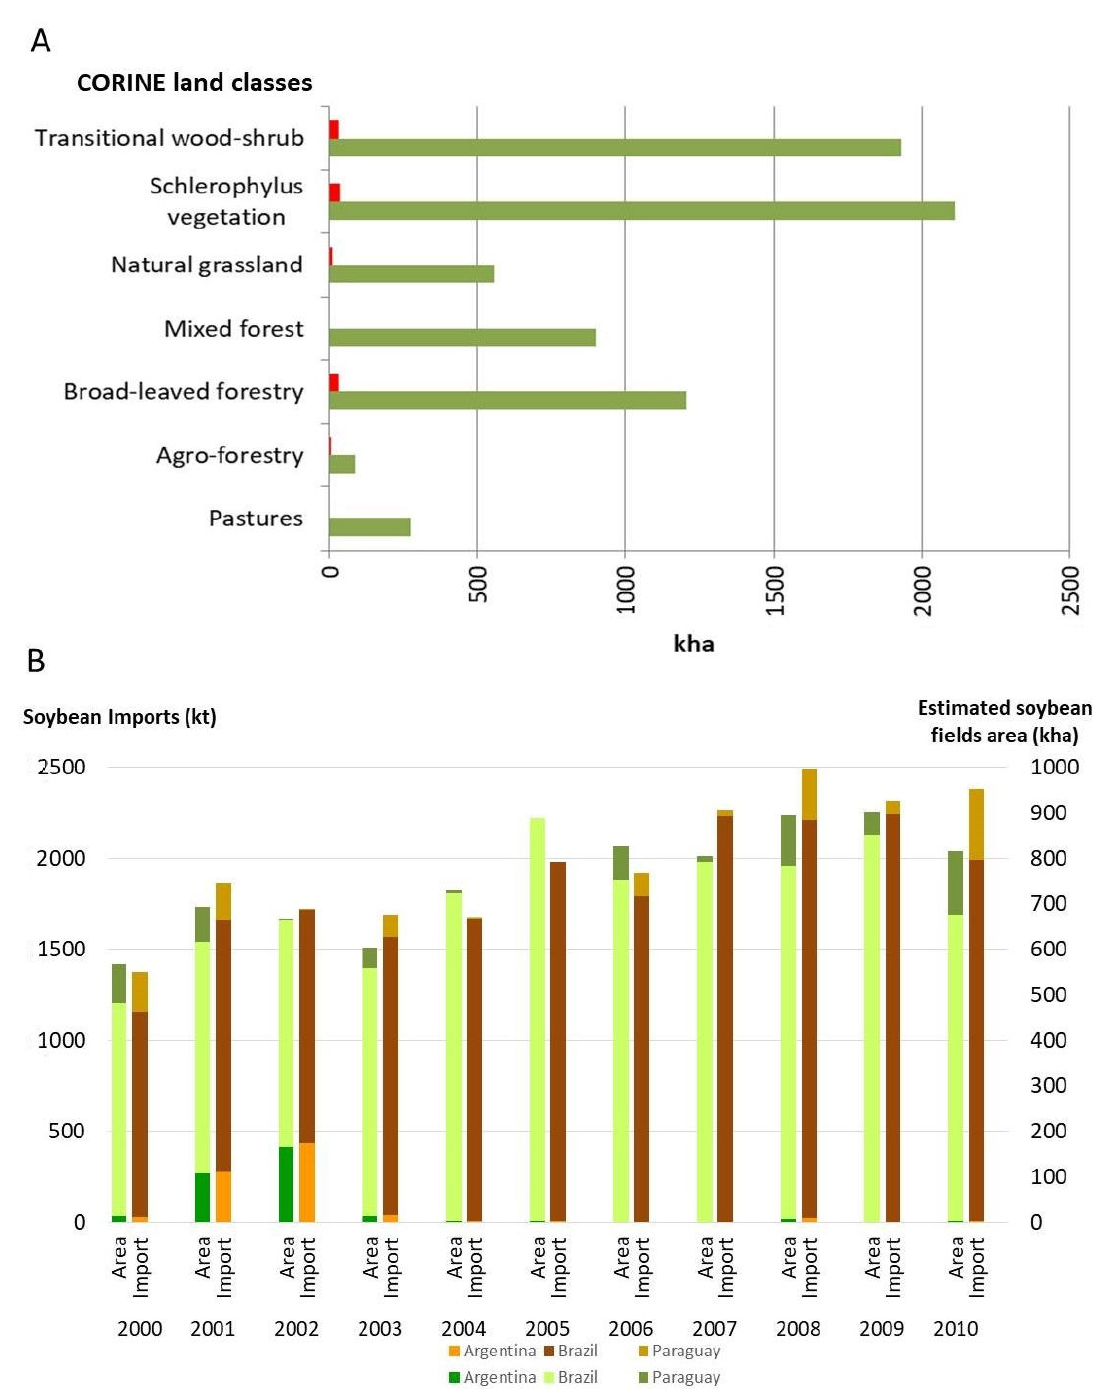
Figure 3. ( A ) ‘Increasing’ (green) and ‘Degrading’ (red) land condition area in Spain for the period 2000–2010 for different CORINE land cover classes [57]; ( B ) Evolution of the estimated area of soybean fields by country of importation and total imports by country (2000–2010). All of the data used in this paper are available in ref.